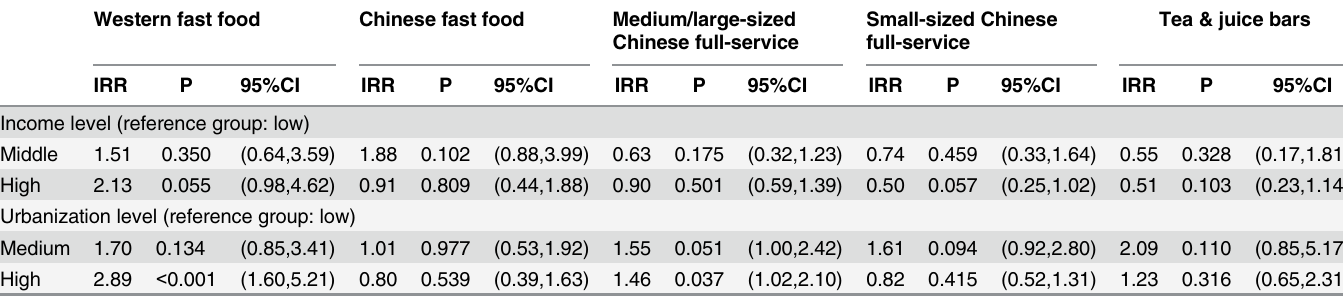
Table 4. Models of the relationship between the numbers of each type of food service places and city level of income and urbanization * . Western fast